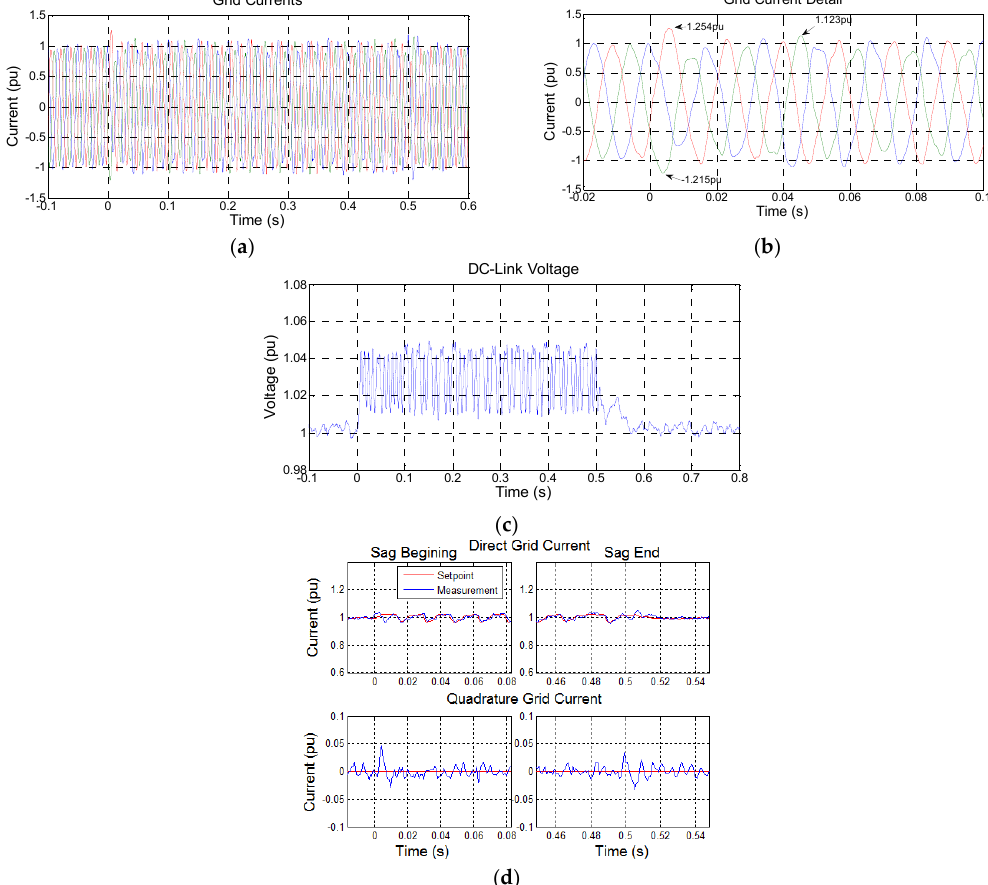
Figure 13. Experimental results for 20% phase ‐ to ‐ phase voltage sag with the system operating at 100% of rated power using RC: ( a ) grid currents; ( b ) grid currents zoom; ( c ) DC ‐ link voltage; and ( d ) direct and quadrature grid currents (sag beginning and recovery instants).